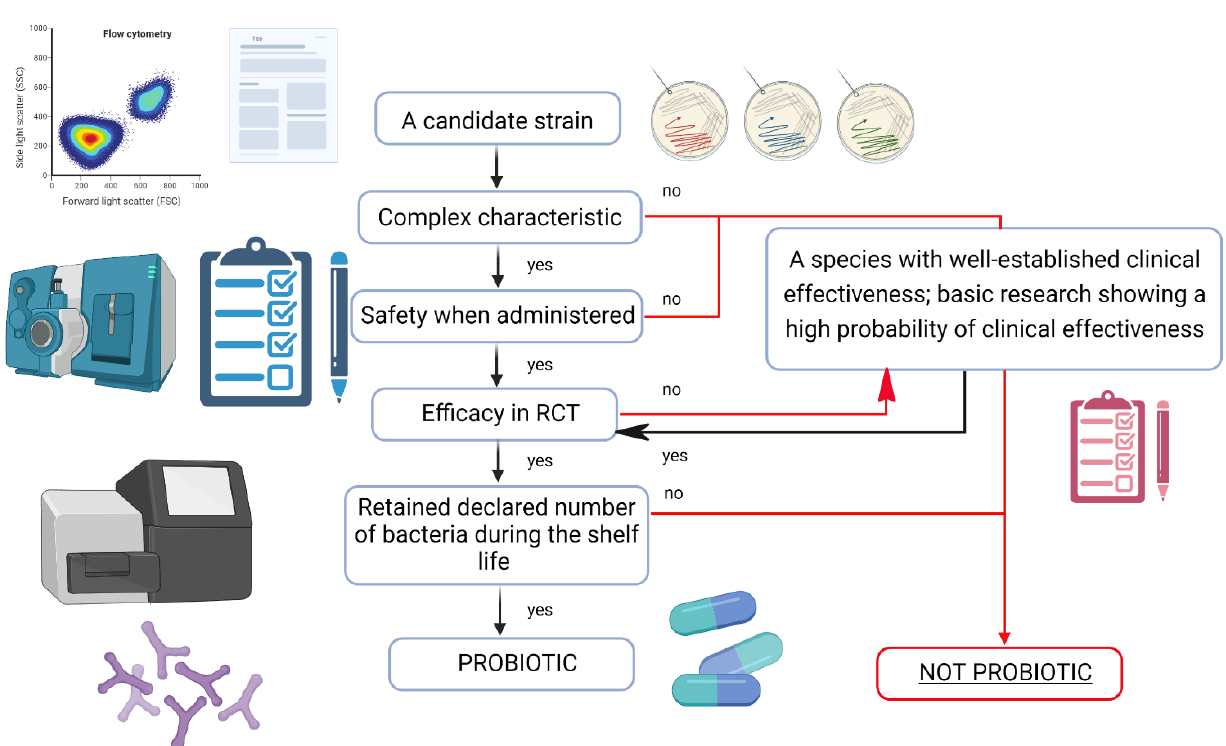
Figure 2. Decision tree for the classification of a strain as a probiotic (Adapted from [94]).